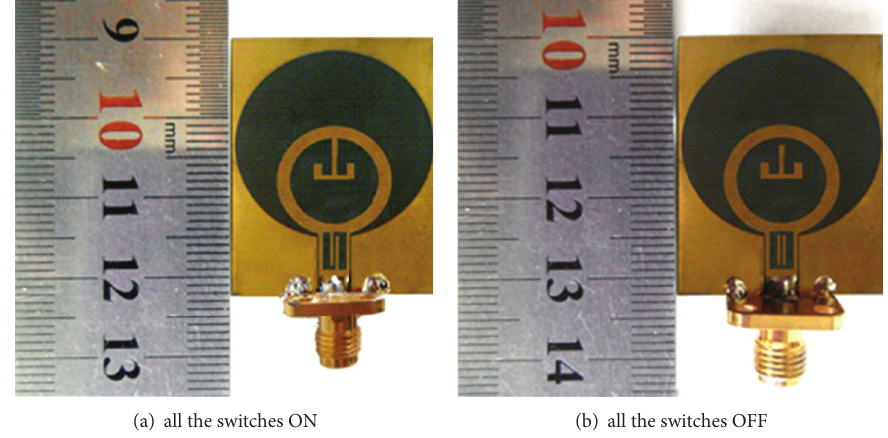
Figure 6: Prototypes of the fabricated antennas.